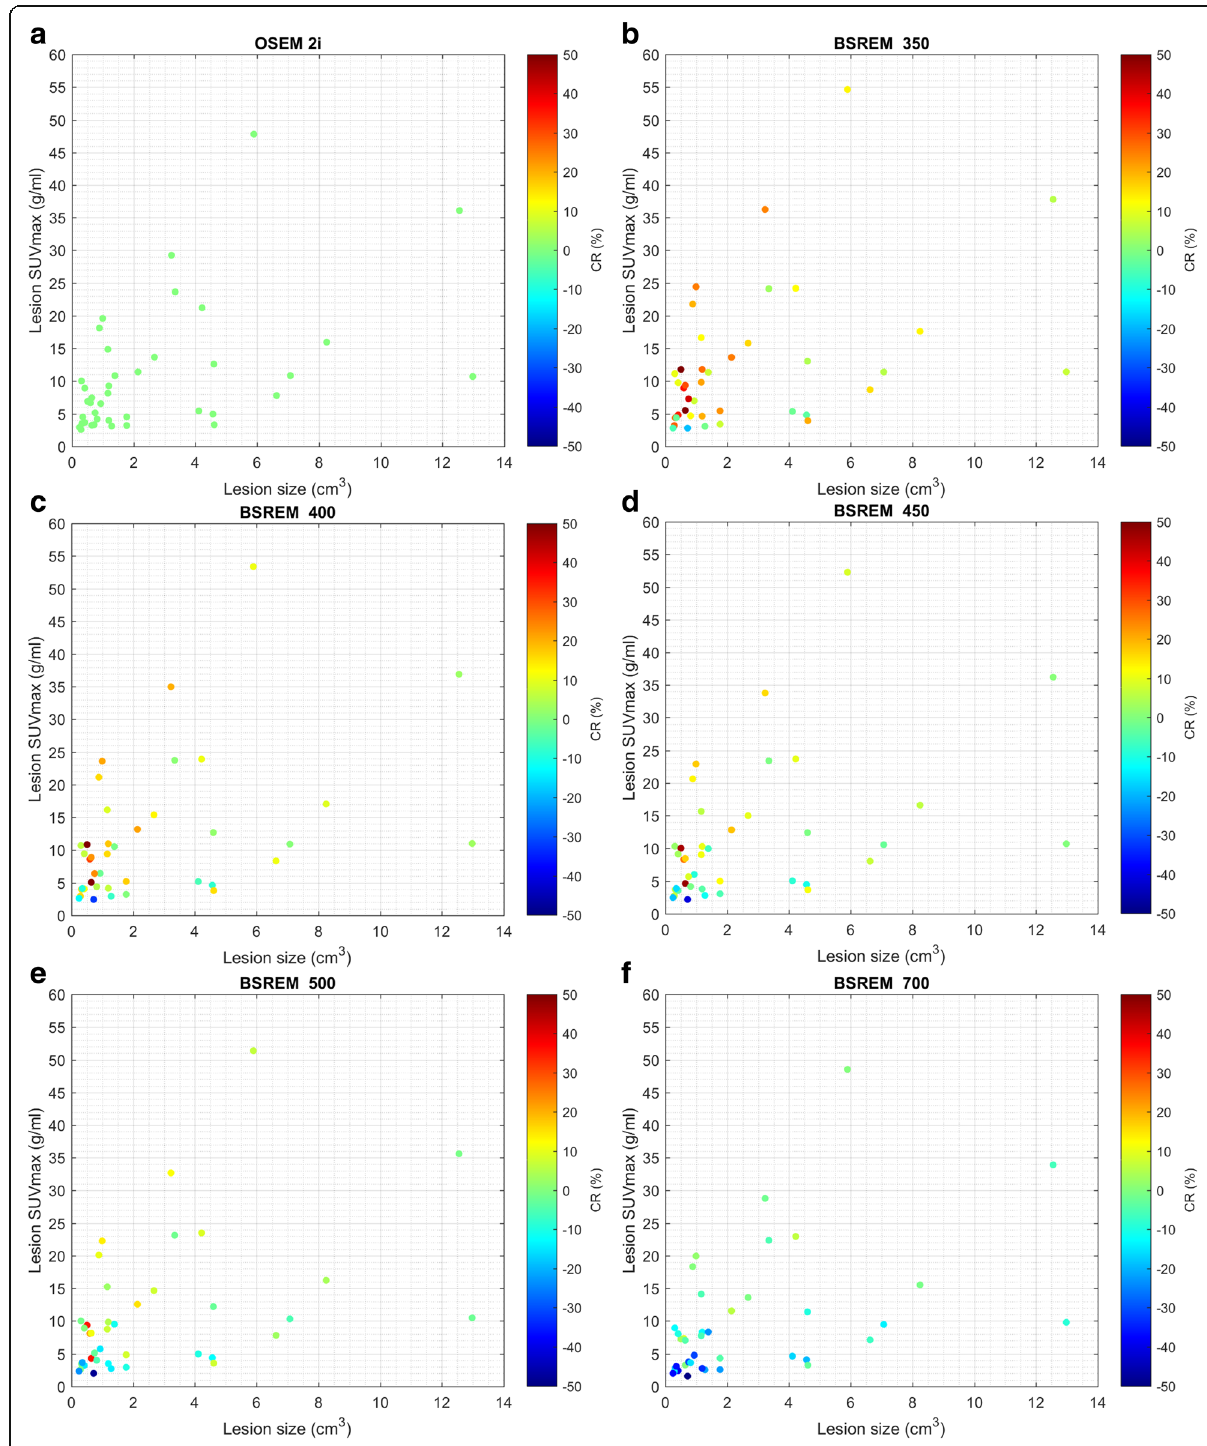
Fig. 6 Scatterplots showing lesion size, SUVmax, and CR increase obtained in 25 patients. Each panel represents a different reconstruction: TOF OSEM with 28 subsets and 2 iterations ( a ), TOF BSREM with regularization parameter β = 350 ( b ), 400 ( c ), 450 ( d ), 500 ( e ), and 700 ( f ). The CR range was limited from − 50 to 50% for clarity. It can be appreciated that with increasing β value, the SUVmax and CR decreases in all lesions. SUV standardized uptake value, SUVmax the average of the hottest 5 voxels in the lesion, CR the percentage increase of the tumor to background ratio of the indicated reconstruction compared to the reference TOF OSEM reconstruction with 2 iterations and 28 subsets. TOF time-of-flight, OSEM ordered subset expectation maximization, BSREM block sequential regularized expectation